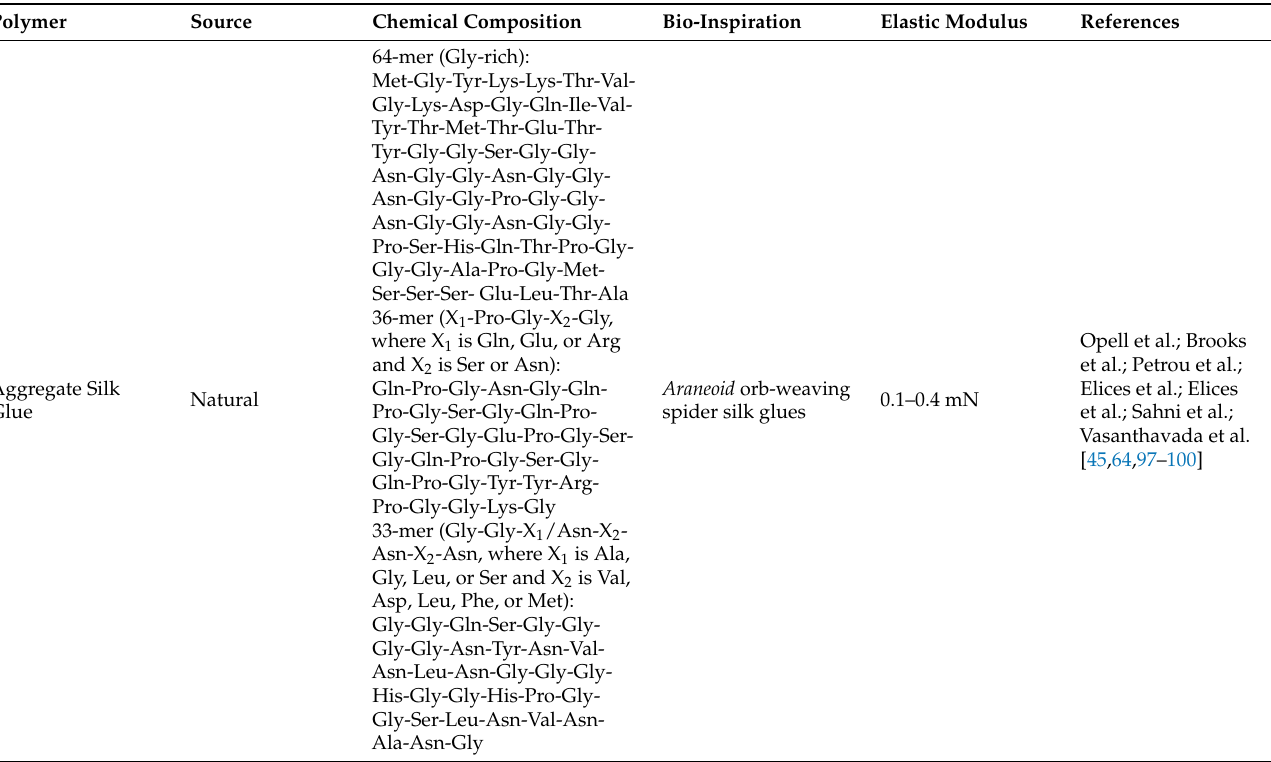
Table 2. Bio-inspired Muco-adhesive Polymer and their